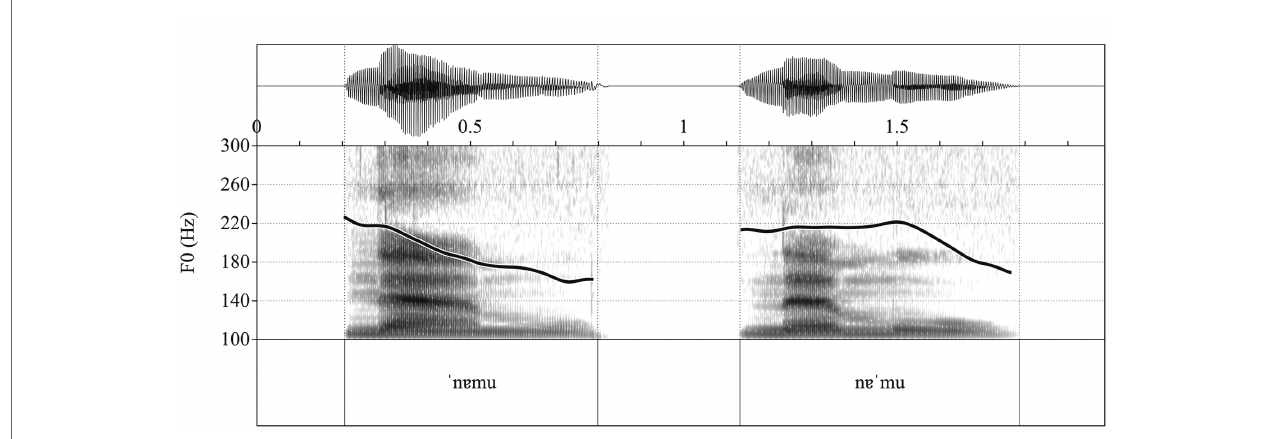
FIGURE 1 | Pitch contours for trochaic stress (pitch fall on the penult syllable) and iambic stress (pitch fall on the final syllable).